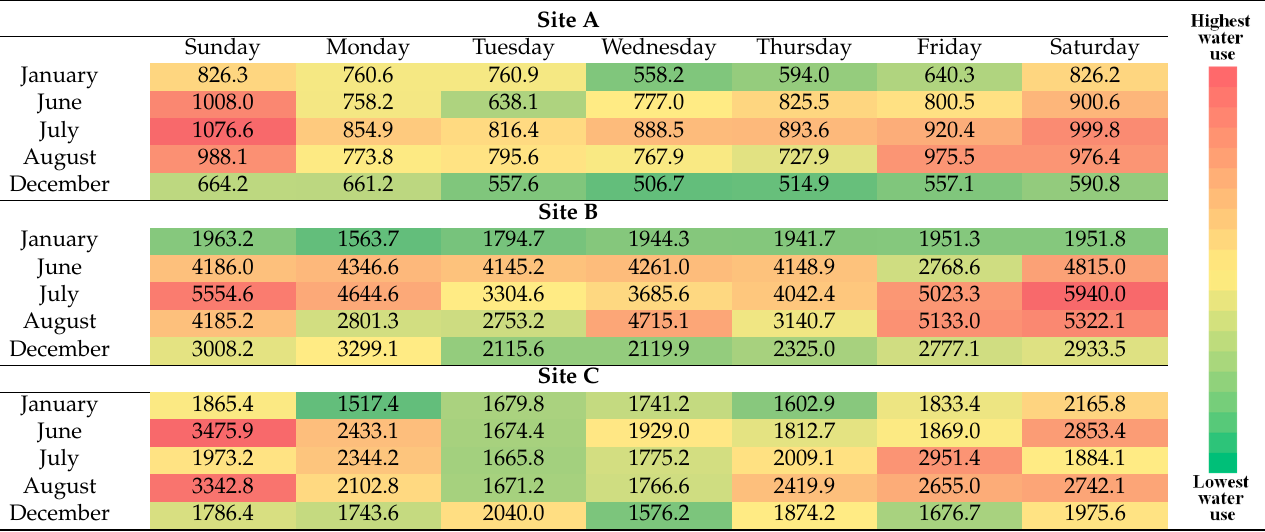
Table 3. Water use (gallons/day) for the three sites for the months of June–August, January and December for the period of